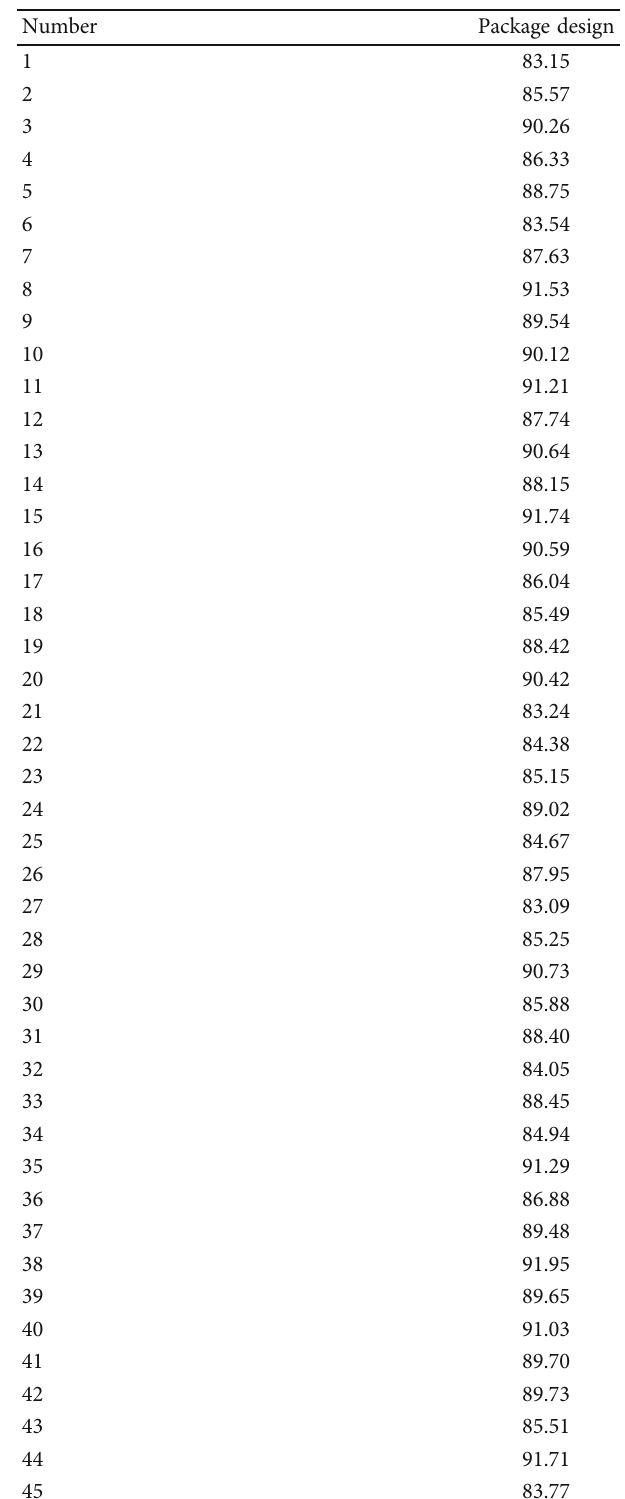
Table 1: E ff ect evaluation of modern packaging design system based on 3D digital image